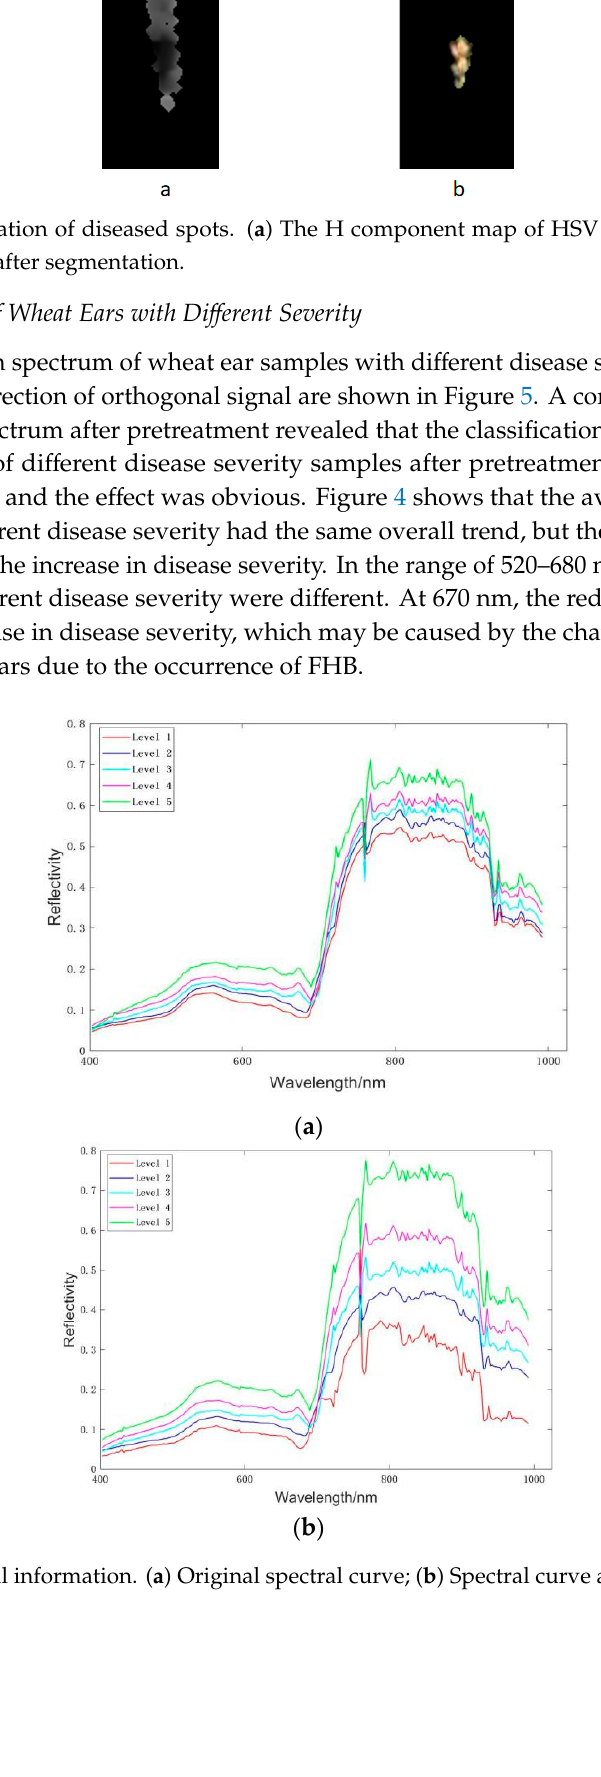
Figure 5. Spectral information. ( a ) Original spectral curve; ( b ) Spectral curve after pretreatment.